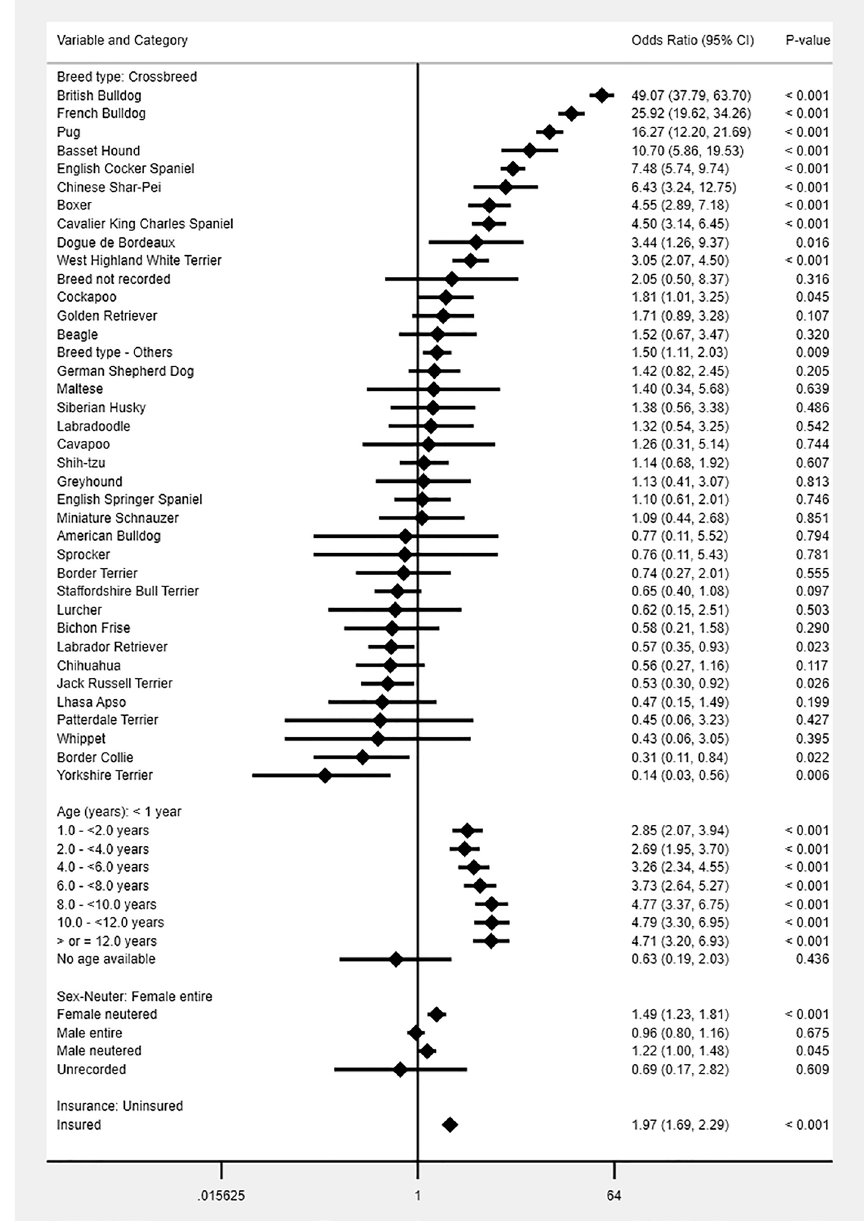
Figure 2. Final breed-focused mixed effects multivariable logistic regression model for risk factors associated with skin fold dermatitis in dogs under primary veterinary care in the VetCompass Programme in the UK. Clinic attended was included as a random effect. * CI confidence